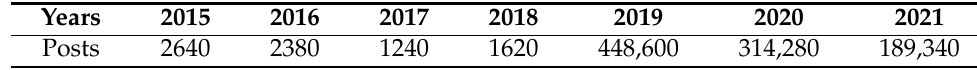
Table 3. User-generated content list.